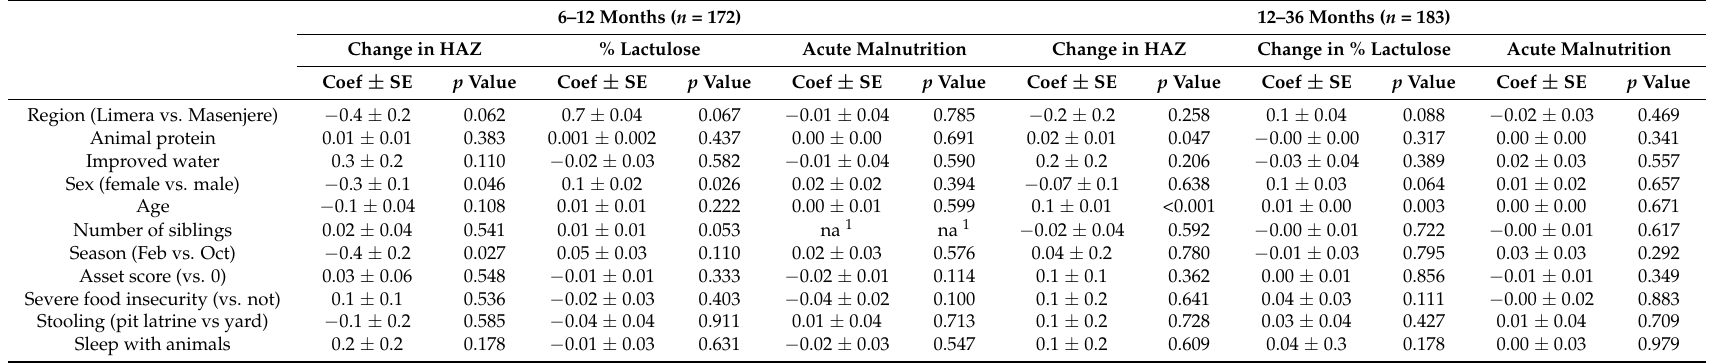
Table 5. Comparison of the association of Height-for-Age z score (HAZ), lactulose % and acute malnutrition, with covariates in children 6–36 months old who participated in 24-h dietary recalls using multiple linear regression.